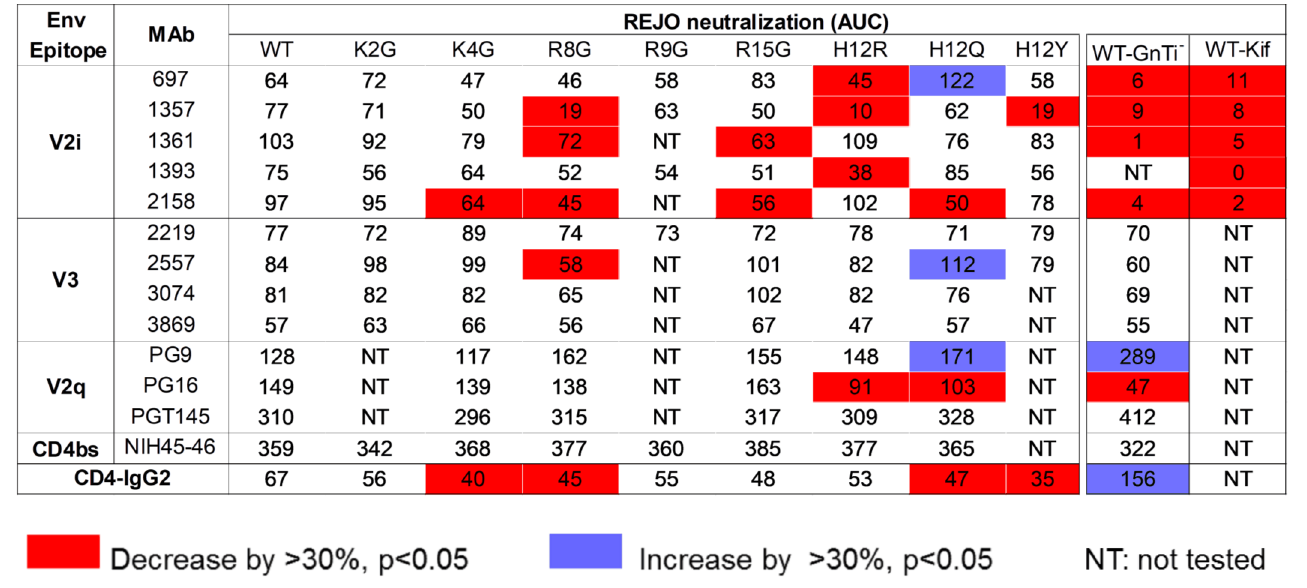
Fig 3. AUC values of REJO WT and SP mutant neutralization by MAbs targeting V2i, V3, V2q, and the CD4bs and by CD-IgG2. Neutralization assays were performed for each of the MAb-virus pairs as described in Fig 2, and areas under the titration curves (AUCs) were calculated. AUCs that decreased or increased by > 30% and had p < 0.05 relative to the corresponding values for WT neutralization by the same MAbs or CD4-IgG2 are shown in red or blue. Neutralization data of REJO WT viruses produced in 293S GnTI - cells or in 293T cells in the presence of kifunensine are included for comparison.